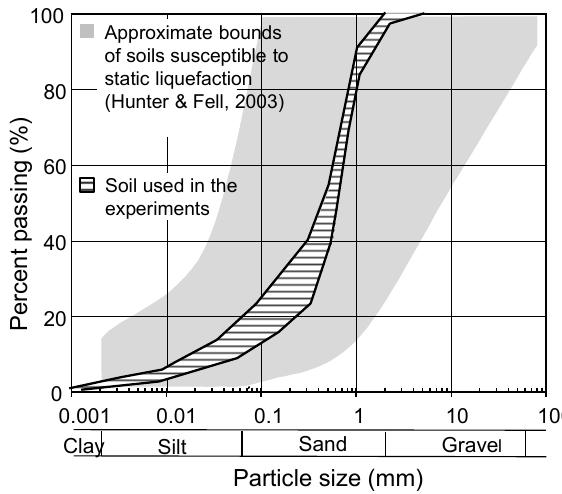
Figure 3. Grain size distribution of the Cervinara ash and range of soils which are susceptible to liquefaction.